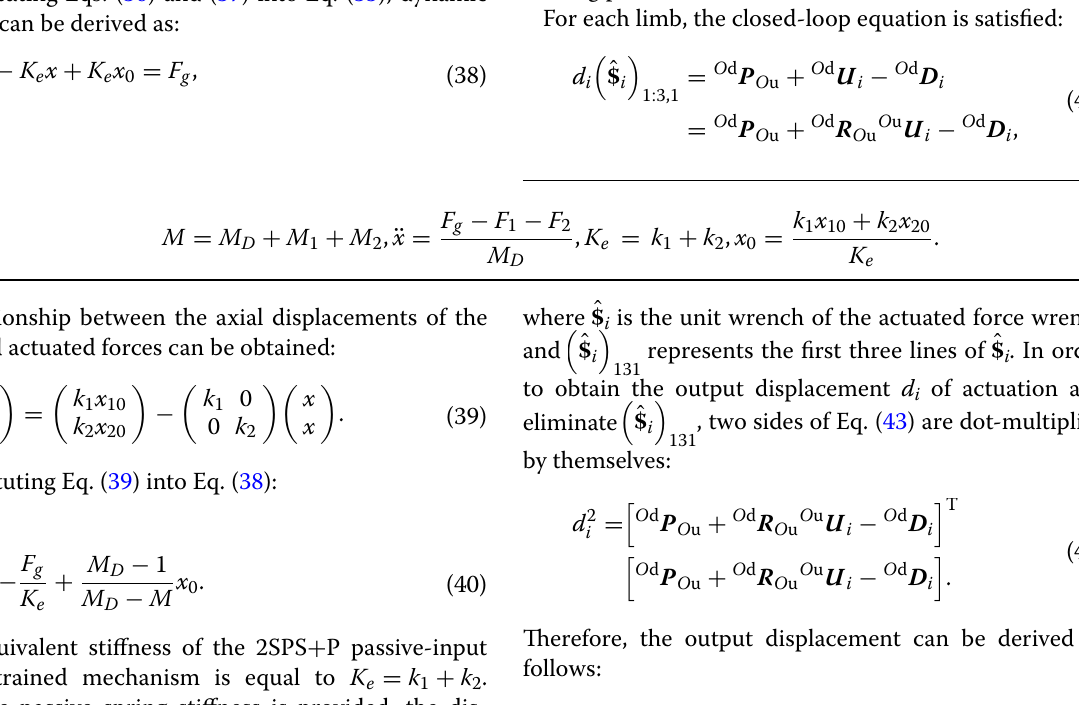
where M D , M 1 and M 2 represent masses of the moving platform and the two limb connecting links, respectively.